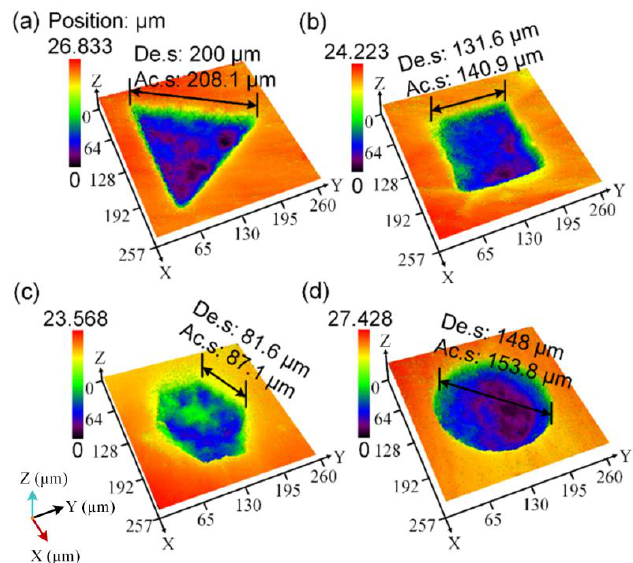
Figure 4. Confocal analysis of the morphology of micro-pits with different shapes. ( a ) Triangular. ( b ) Quadrilateral. ( c ) Hexagonal. ( d ) Circular. Abbreviations: De. s, design size; Ac. s, actual sample size.